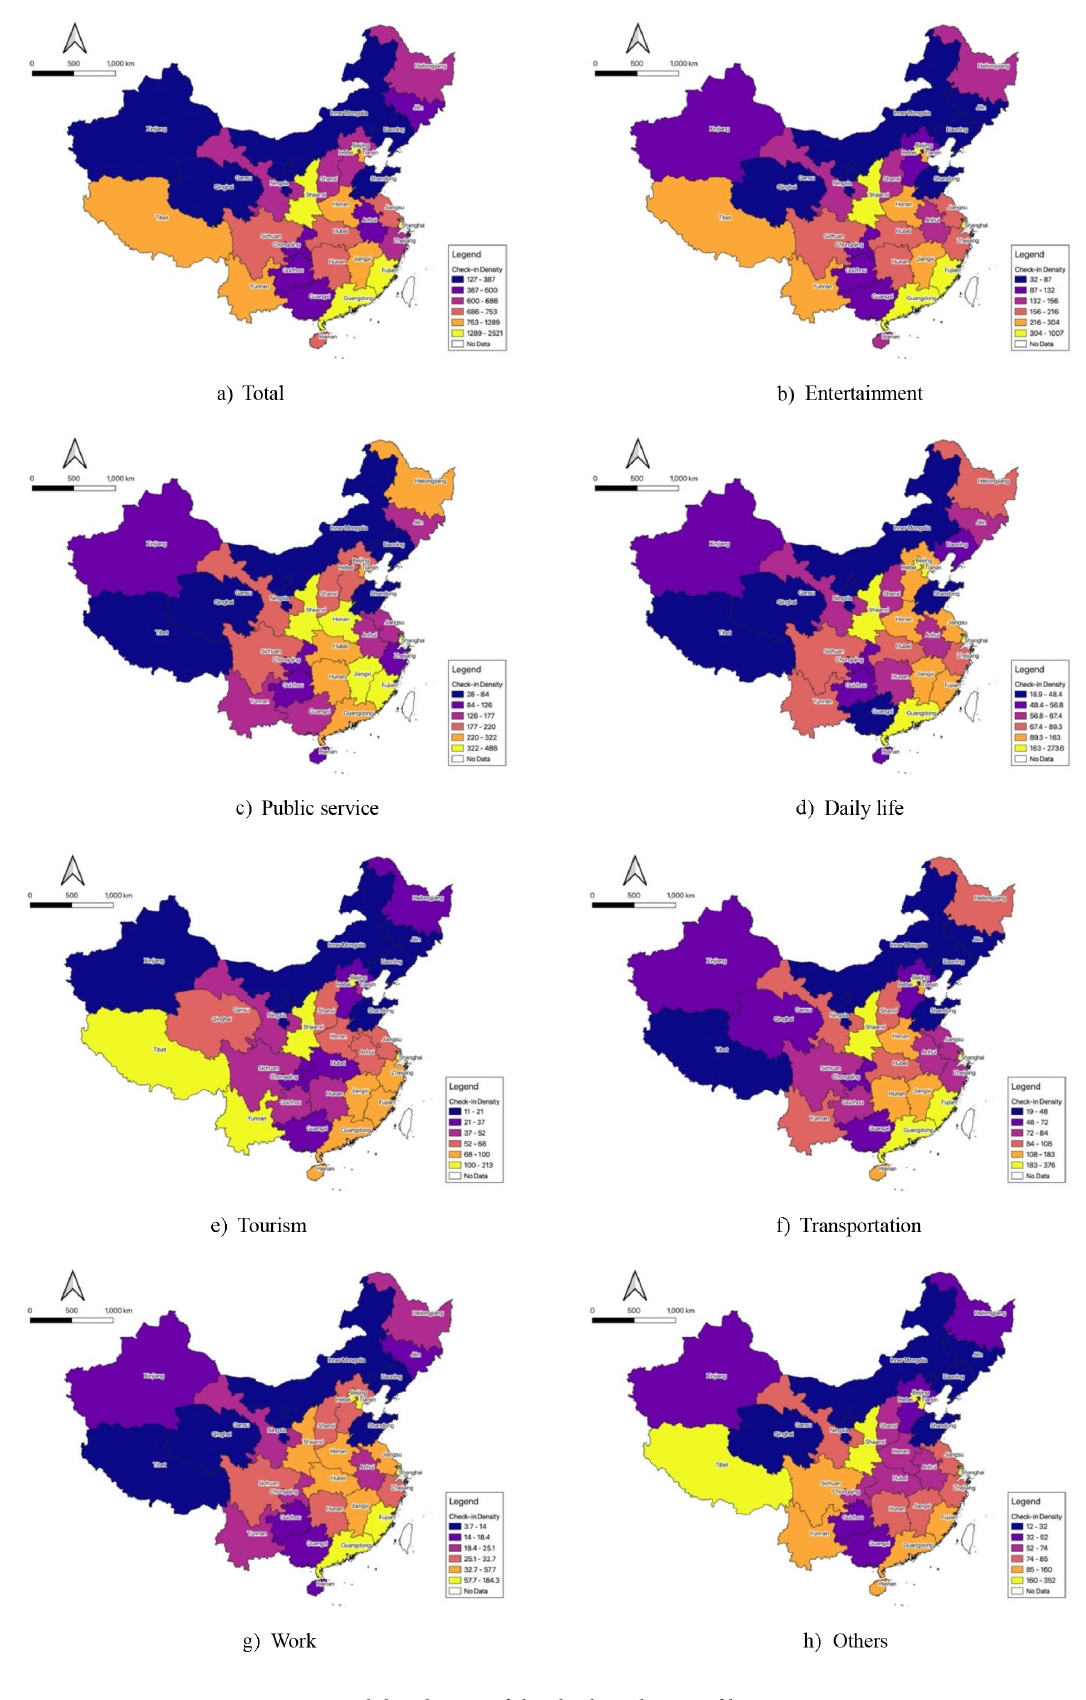
Figure 2. Spatial distribution of the check-in density of human